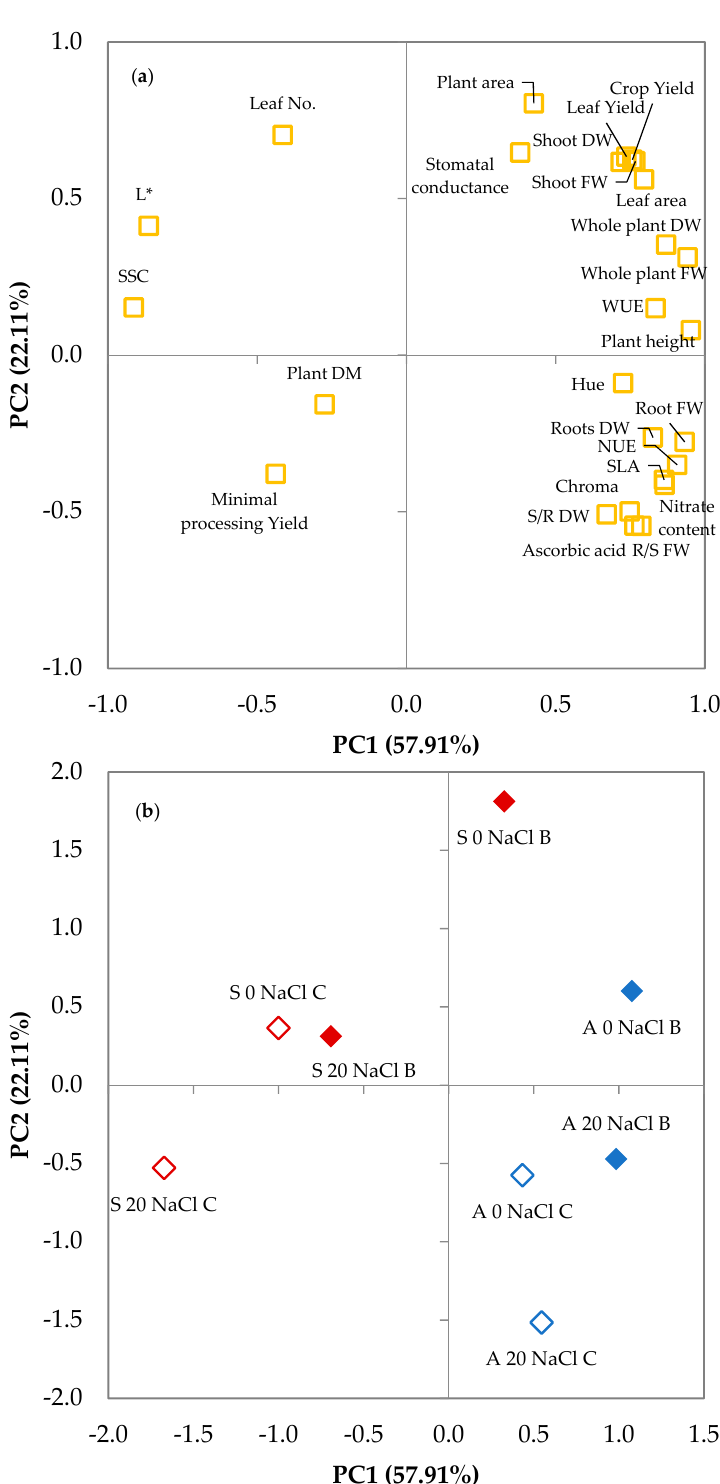
Figure 10. Plot of ( a ) loadings (morphophysiological and quality characteristics of leaf lettuce plants) and ( b ) scores (trials) formed by the two principal components from the Principal Component Analysis (PCA). A: autumn cultivation (blue color); S: spring cultivation (red color); 0 NaCl, 20 NaCl: mM of NaCl in the nutrient solution; C: nutrient solutions not inoculated with the bacterial biostimulant (empty symbol); and B: nutrient solutions inoculated with the bacterial biostimulant (full symbol).